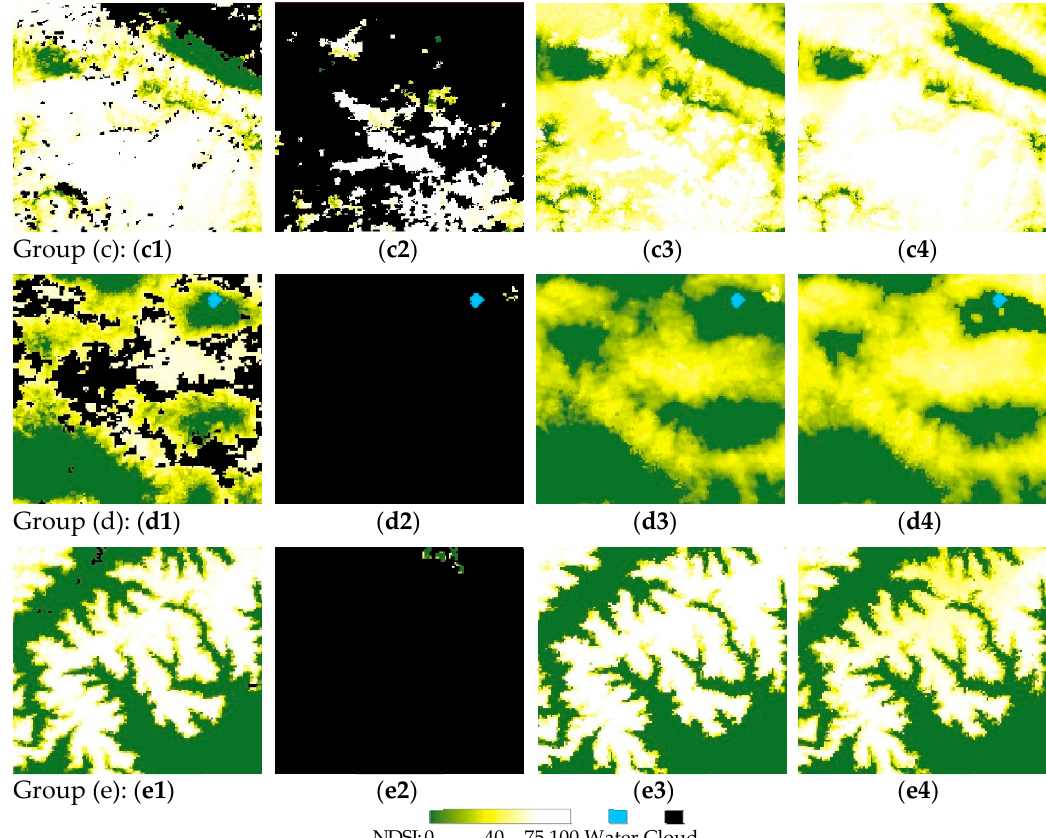
Figure 10. The three specific effects (groups (c)–(e)) of error correction extracted from the results for 24 March 2016. ( c1 , d1,e1 ) “Ground truth”. ( c2,d2,e2 ) “Observed data”. ( c3,d3,e3 ) The cloud-removed results of the method without error correction. ( c4,d4,e4 ) The cloud-removed results of STF-GKF-EC.